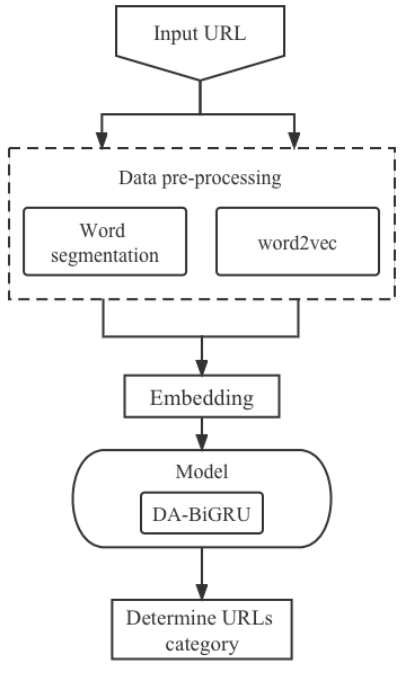
Figure 8. Experimental process.